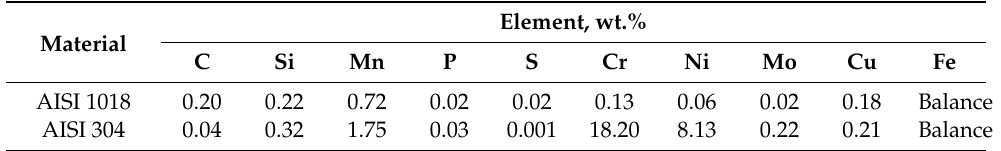
Table 5. Elemental composition (wt.%) of the reinforcements tested, AISI 1018 carbon steel (CS) and austenitic AISI 304 SS.